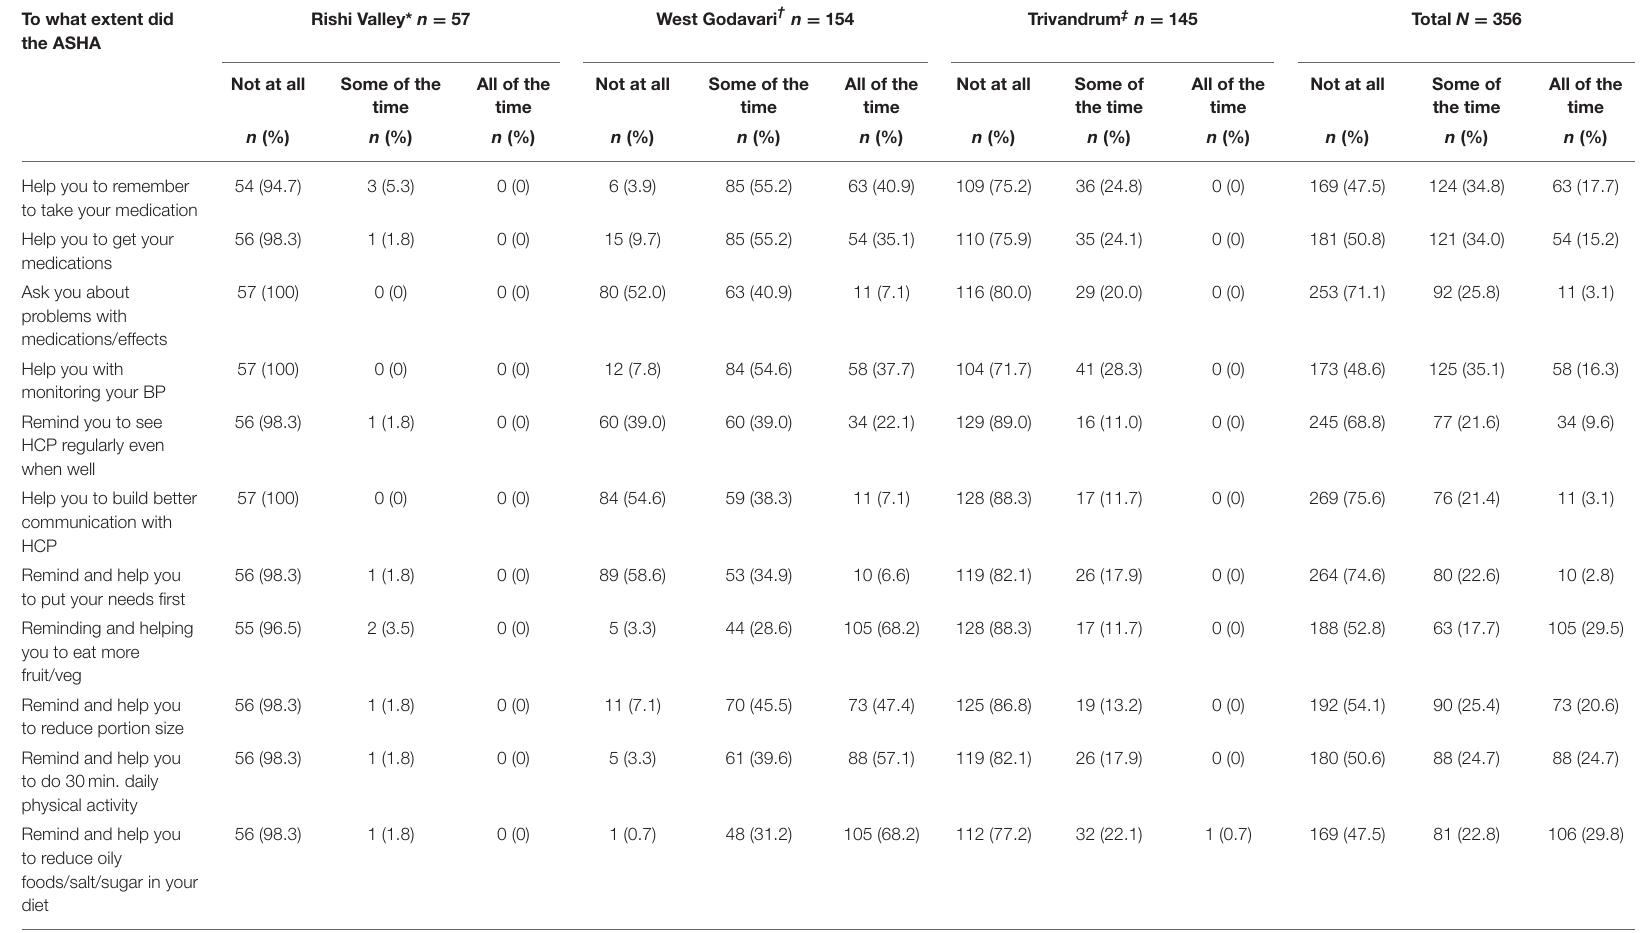
TABLE 5 | Participant evaluation of help from ASHAs during the group meetings to manage high BP on a day-to-day basis. To what extent did the